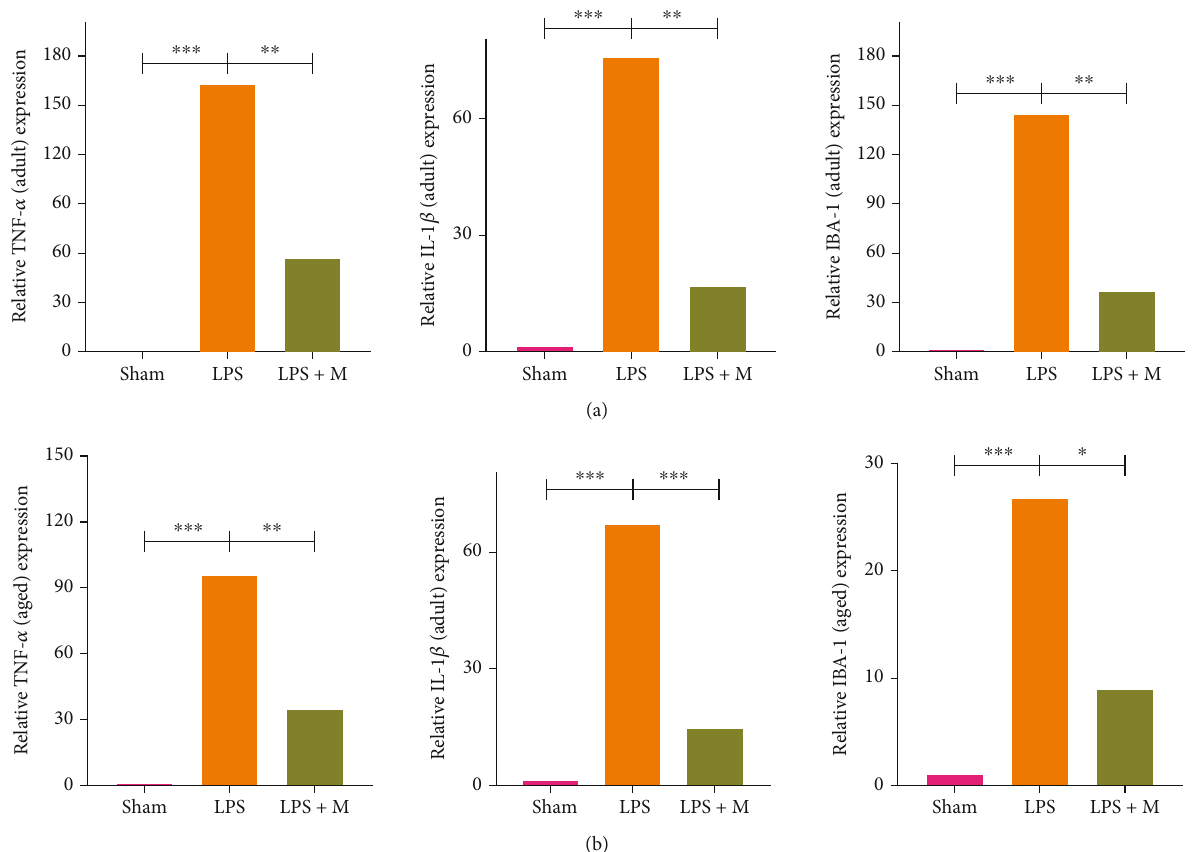
Figure 5: E ff ect of metformin on the expression of in fl ammatory factor gene in brain tissue of SAE-induced mice. The gene expression levels of in fl ammatory factors, TNF- α , IL-1 β , and Iba-1 were detected by qPCR assay among groups (a, b). ∗ p < 0 : 05 , ∗∗ p < 0 : 01 , ∗∗∗ p < 0 : 001 . n = 10 in each group. qPCR: quantitative polymerase chain reaction; TNF- α : tumor necrosis factor- α ; IL-1 β : interleukin-1 β ; LPS: lipopolysaccharide; LPS + M : lipopolysaccharide and